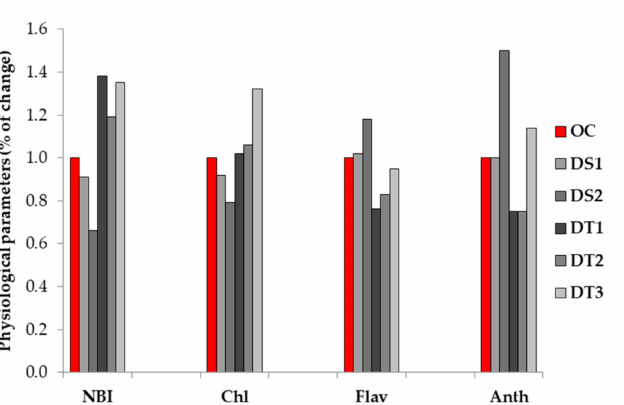
Figure 1. The percentage of changes for indices measured under water deficit stress (non-irrigation treatment—I 0 ) compared to the optimal conditions (irrigation treatment—I 75 ) evidenced in drought tolerant (DT1, DT2, and DT3) and drought susceptible (DS1 and DS2) inbreds. OC—values measured under optimal conditions given as 1